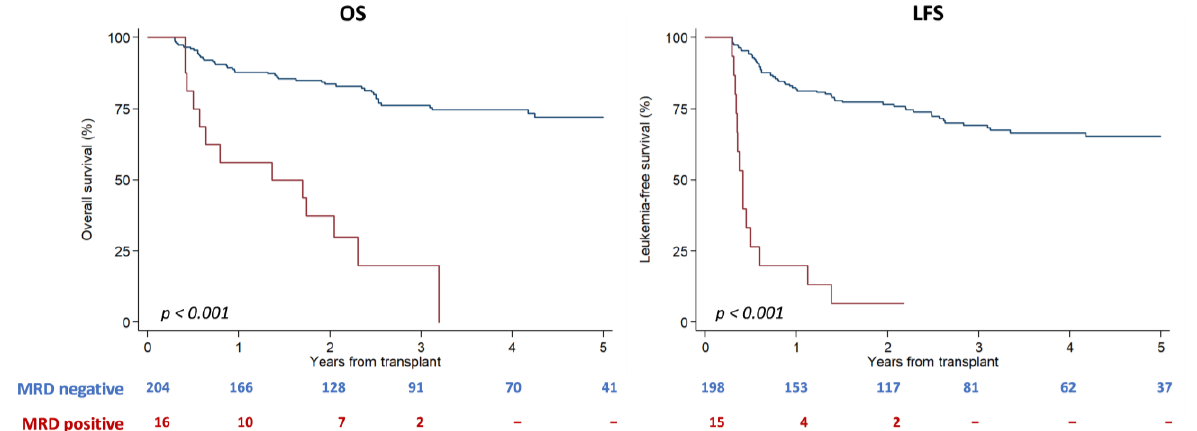
Figure 5. Impact of MRD on day +100 after transplantation. At 2 years, OS and LFS were signifi-